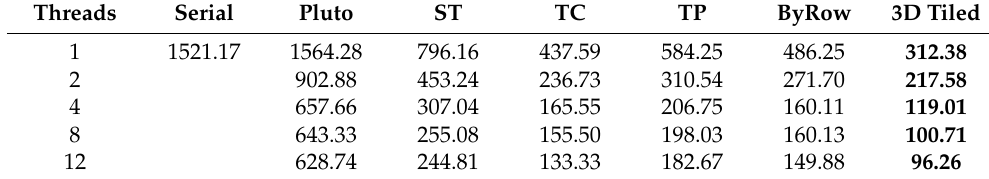
Figure 2. Speedup for Intel i7-8700 and 12 threads. Table 4. Time in seconds for Intel i7-8700 and N = 10,000 (ST, TC, and TP denote the codes generated on the basis of the space-time, tile correction, and transpose approaches, respectively).